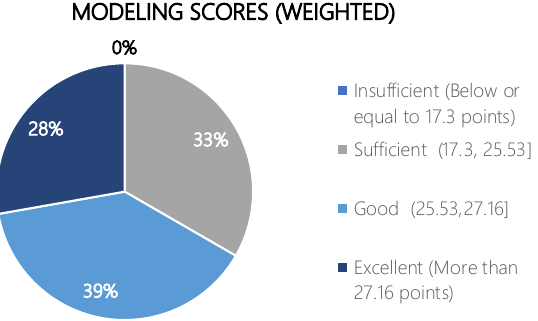
Figure 20. Modeling